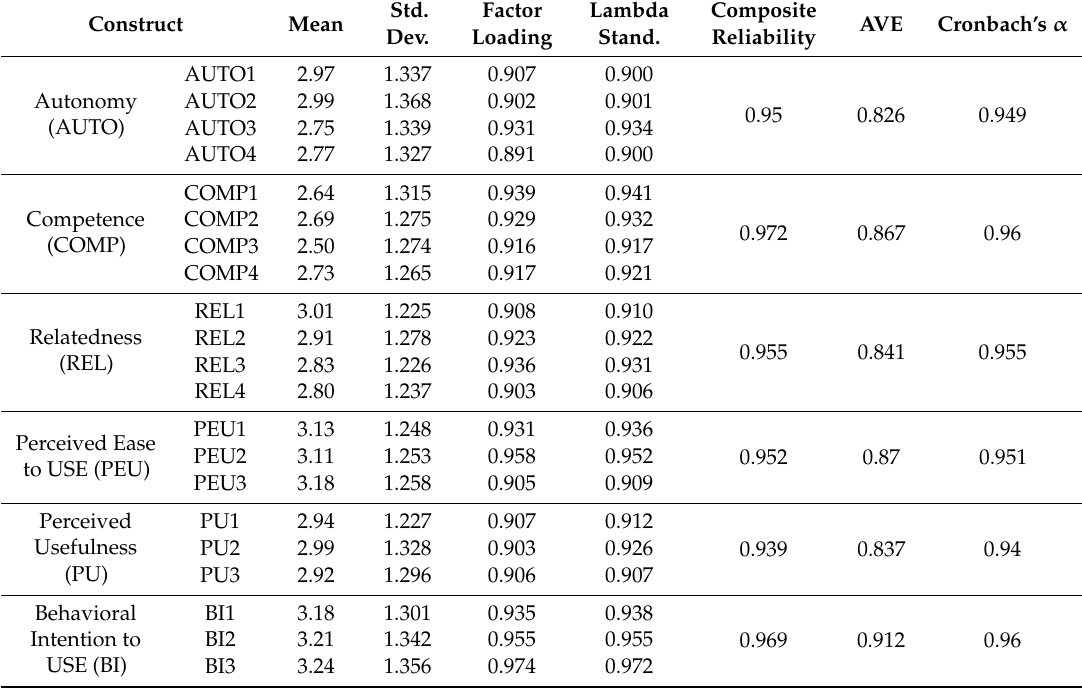
Table 2. Item loadings and measurement